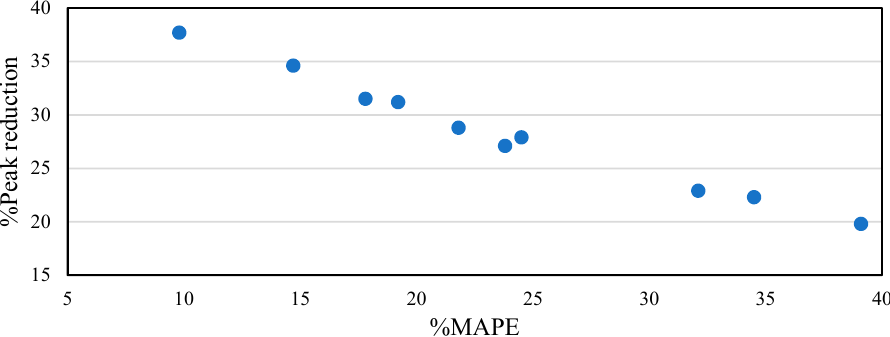
Figure 7. The daily peak reduction for the SMPC controller over different forecast accuracy level.